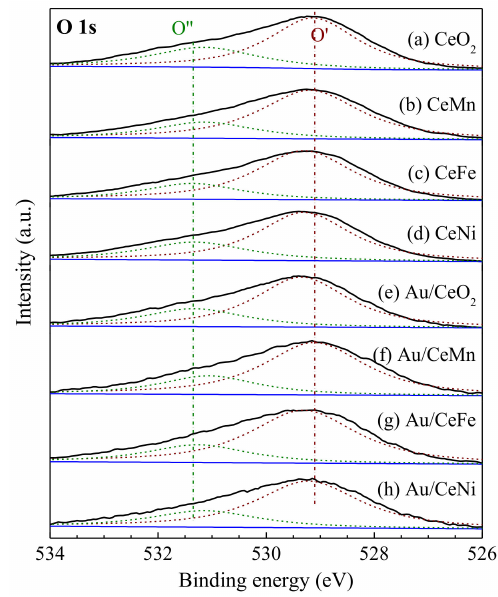
Figure 8. O 1 s XPS spectra of Au catalysts supported on CeO 2 and CeM mixed oxides with different dopants: ( a ) CeO 2 ; ( b ) CeMn; ( c ) CeFe; ( d ) CeNi; ( e ) Au/CeO 2 ; ( f ) Au/CeMn; ( g ) Au/CeFe; ( h ) Au/CeNi.